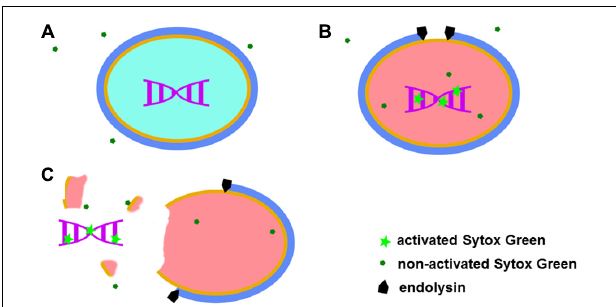
FIGURE 1 | Graphical representation of the Sytox Green mode of action. When added to a bacterial mixture, Sytox Green is excluded from metabolically active (live) bacteria and DNA remain sequestered inside the bacterial cell resulting in no signal (A) . When a bacteriolytic agent (e.g., endolysin) is added to a mixture of live bacteria and Sytox Green, lysis of the bacterial cell begins. The bacterial cell becomes metabolically inactive and dies when sufficient lysis occurs, allowing Sytox Green to enter the cell ghost and bind to DNA resulting in increased fluorescence (B) . In the case of extensive damage or even complete disintegration of the bacteria, bacterial DNA can leak outside the cell and Sytox Green in the mixture binds the DNA producing a signal (C) .